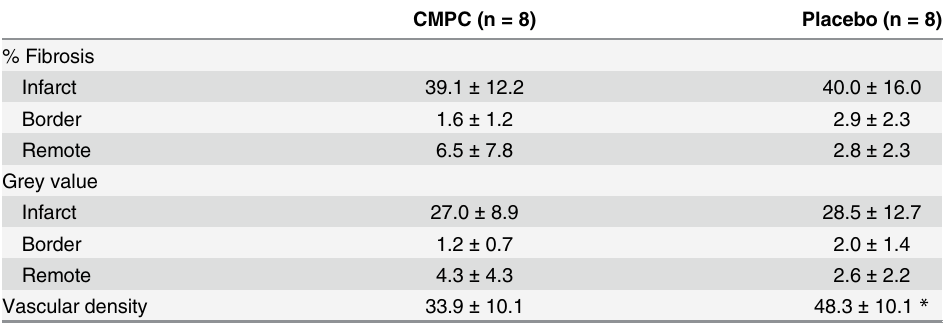
Table 2. Fibrosis.